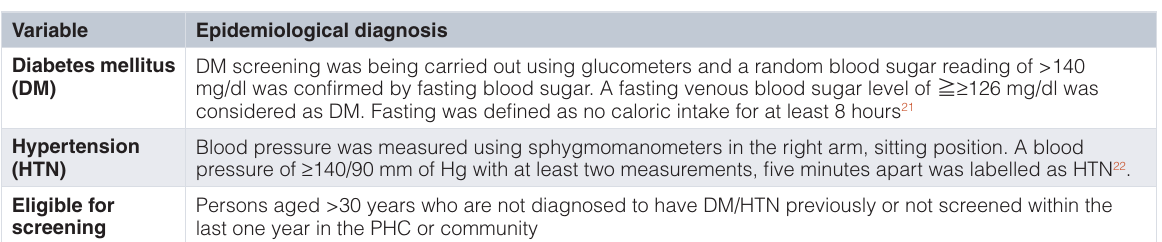
Table 1. Epidemiological diagnosis used in the study.